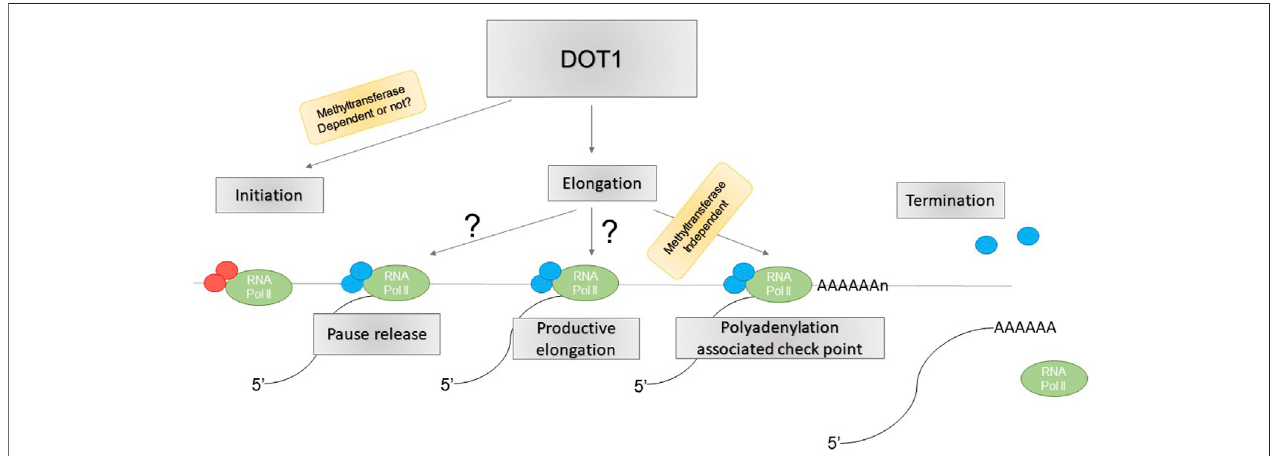
FIGURE 2 | Role of DOT1L in transcription